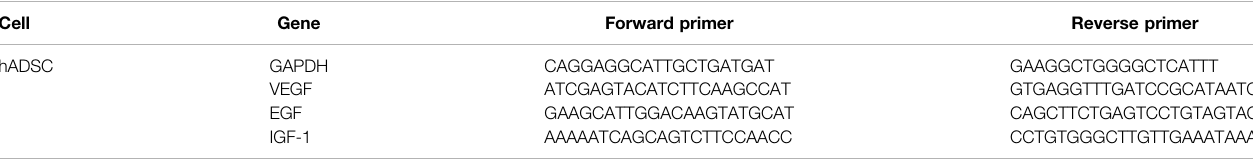
TABLE 1 | Primer sequence for qPCR.